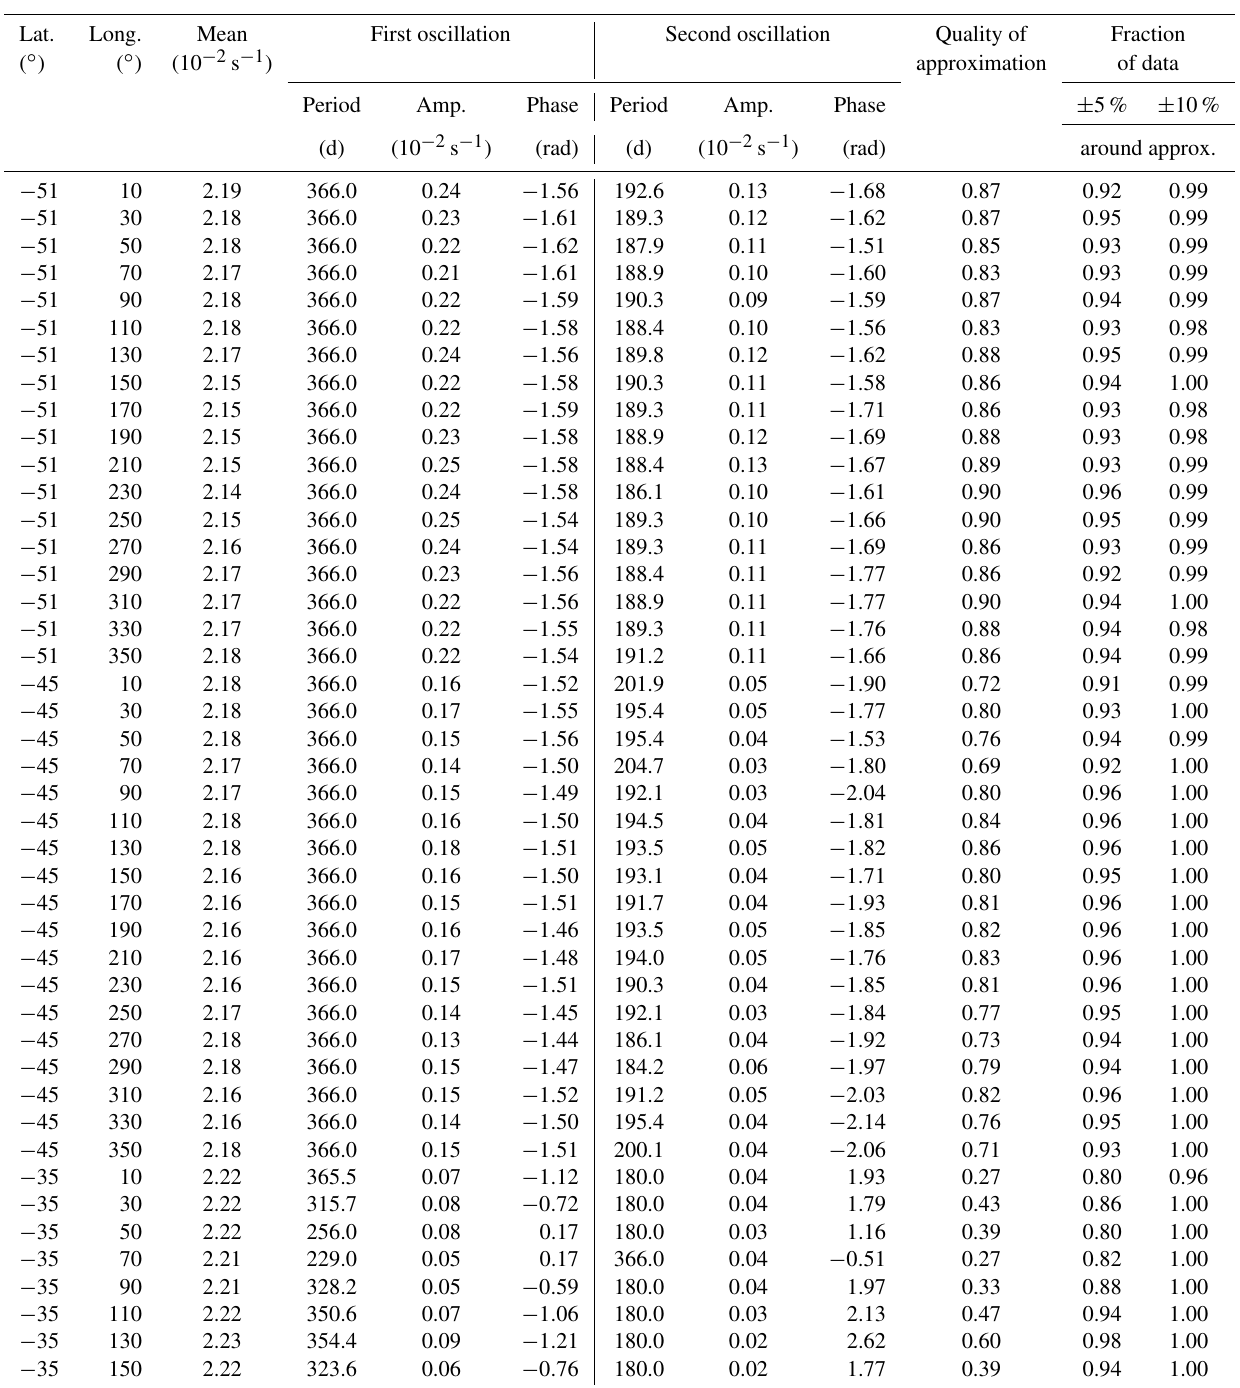
Table 1. Period ( T ), amplitude ( A ) and phase ( ϕ ) of the two oscillations which explain the variability of the daily OH ∗ -equivalent BV frequency values (averaged over all years) best for a latitudinal and longitudinal gridding of 10 ◦ and 20 ◦ . They oscillate around the respective mean. The OH ∗ -equivalent BV frequency (s − 1 ) can be estimated by the mean + (cid:80) 2 i = amount of days for 1 year is set to 366, which means 1 March is DoY 61 for every year. The harmonic oscillation explains the variability in the time series of daily OH ∗ -equivalent BV frequency values to a different extent. The respective value is provided in the column “quality of approximation”. Additionally, the fraction of data which lies within intervals of ± 5% or ± 10% around the harmonic approximation is